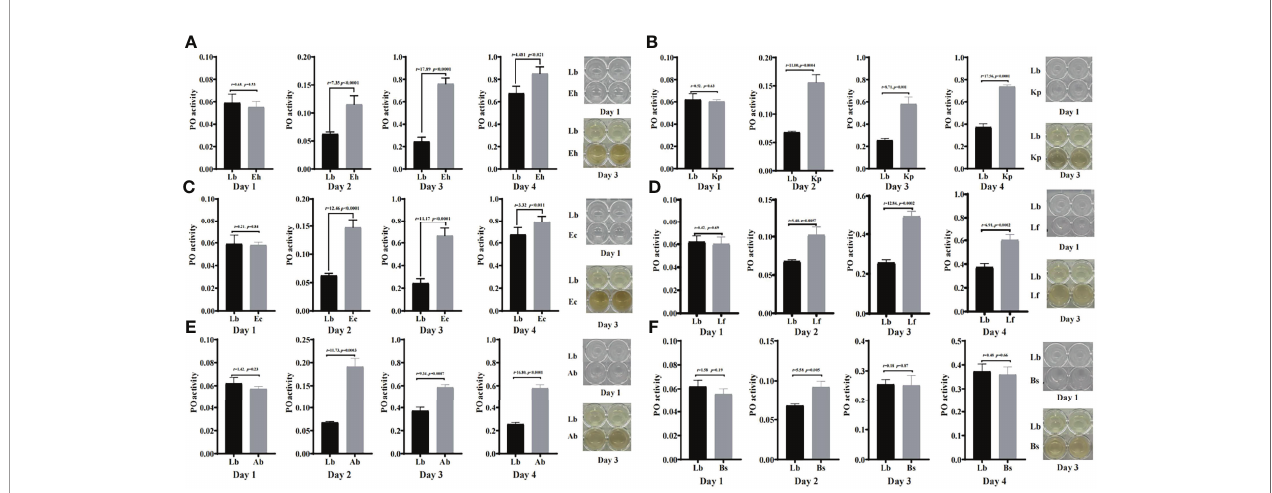
FIGURE 6 | Effects of “ bene fi cial bacteria ” in the guts of house fl y larvae on phenoloxidase activity in the hemolymph. Eh, Enterobacter hormaechei ; Ec:, Enterobacter cloacae ; Bs, Bacillus safensis ; Lf, Lysinibacillus fusiformis ; Ab, Acinetobacter bereziniae ; Kp, Klebsiella pneumoniae . Day 1, Day 2, Day 3, Day 4: the developmental period of house fl y